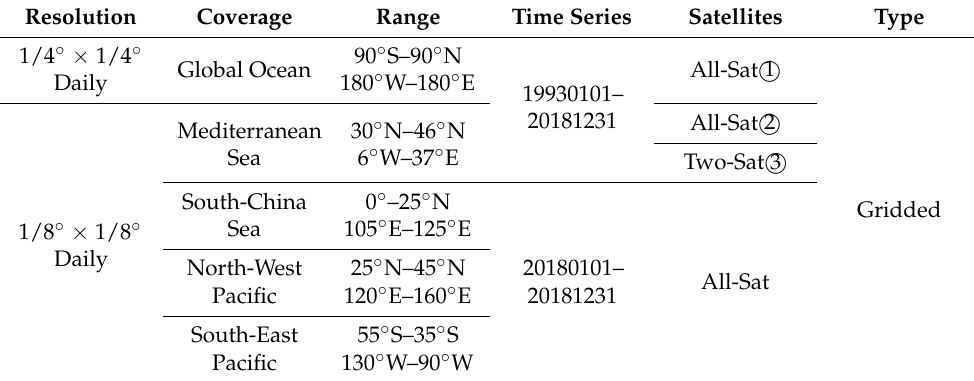
Table 1. Details of the SLA data sets used in this